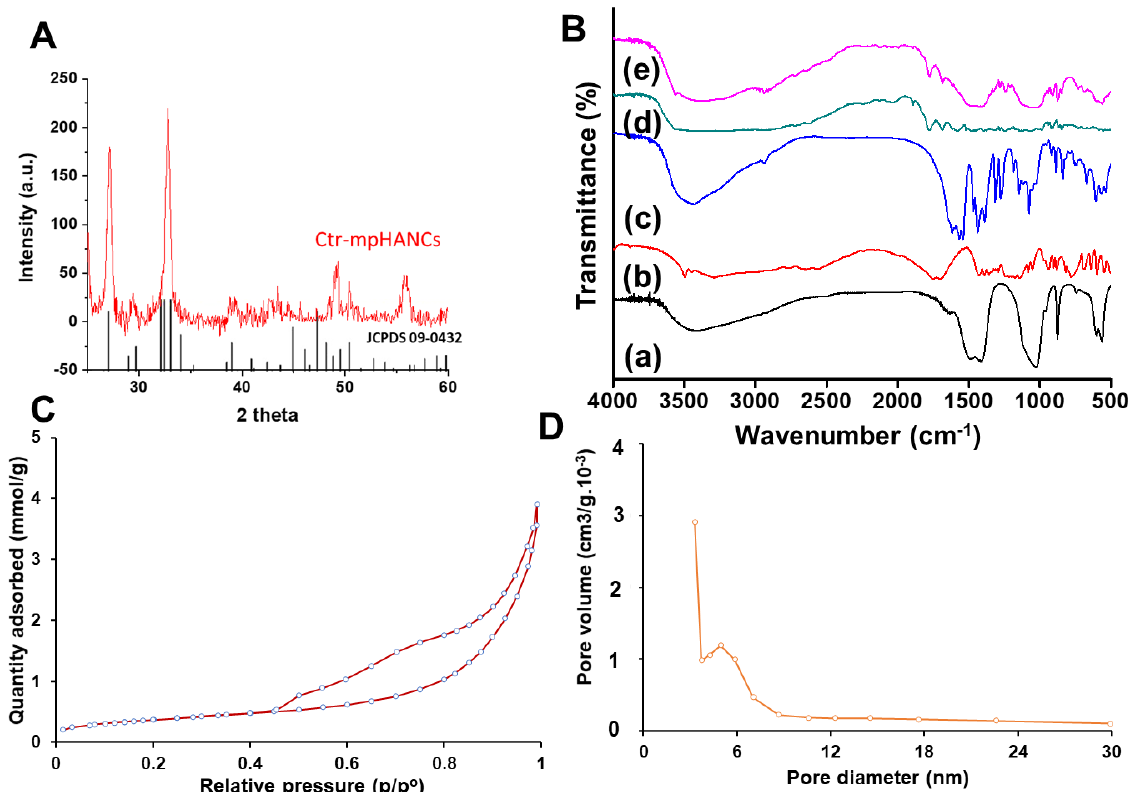
Figure 3. ( A ) XRD patterns of hydroxyapatite (JCDPS file no. 09-0432) and Ctr–mpHANCs; ( B )